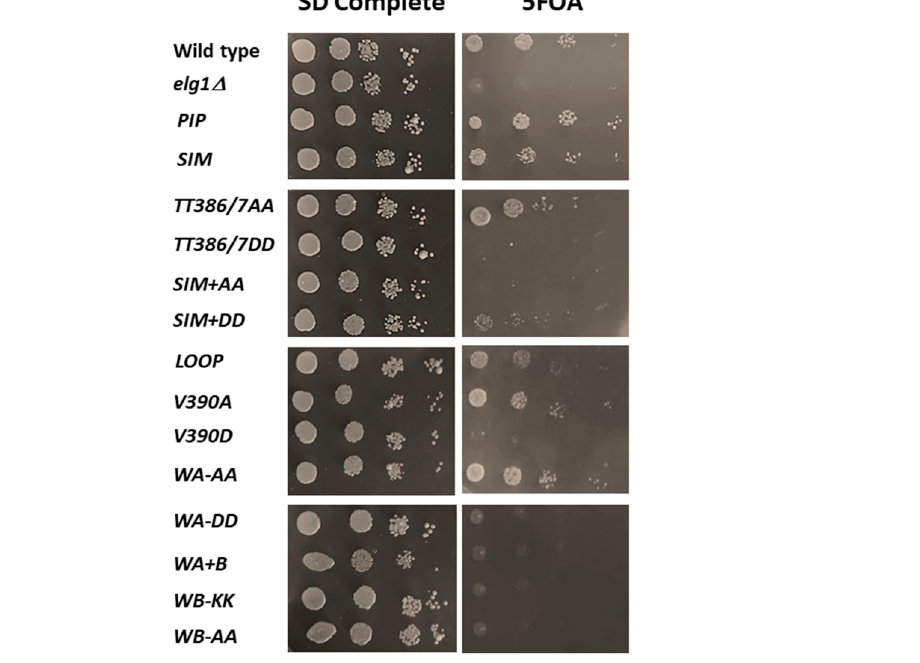
Figure 4. Rescue of the synthetic lethality of elg1 ∆ srs2 ∆ . Diploid stains homozygous for ELG1 and SRS2 genomic deletions are kept alive by the presence of a plasmid carrying the ELG1 and URA3 genes. We introduced into these strains the elg1 allele collection on LEU2 -marked pRS415 vectors. 5-FOA-containing medium selects for cells able to lose the URA3-ELG1 covering plasmid. The strain described as “Wild type” carried the ELG1 gene, and the one described as “ elg1 Δ ” carried an empty pRS415 vector.